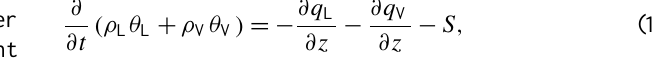
method weekly. Crop ET was determined using the lysime- ter weighting system (with an accuracy of 0.021 mm). The